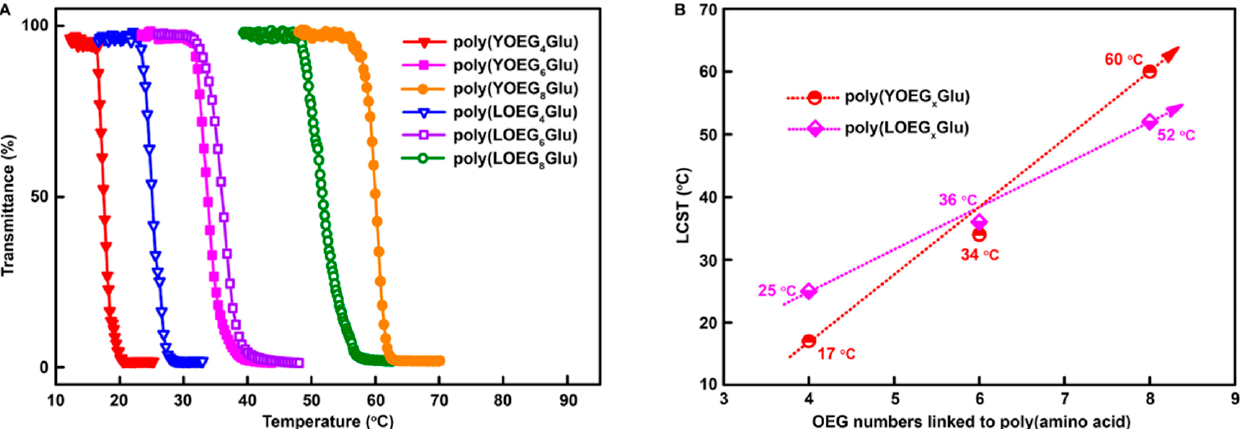
Figure 12. ( A ) Profiles of transmittance vs temperature for the aqueous solutions (2 mg/mL) of poly(LOEG x Glu)s and poly(YOEG x Glu)s. ( B ) LCSTs of poly(LOEGxGlu)s ( ◆ ) and poly(YOEGxGlu)s ( ● ); x represents the number of OEG units. Reproduced with permission [27]. Copyright 2019, American Chemical Society.